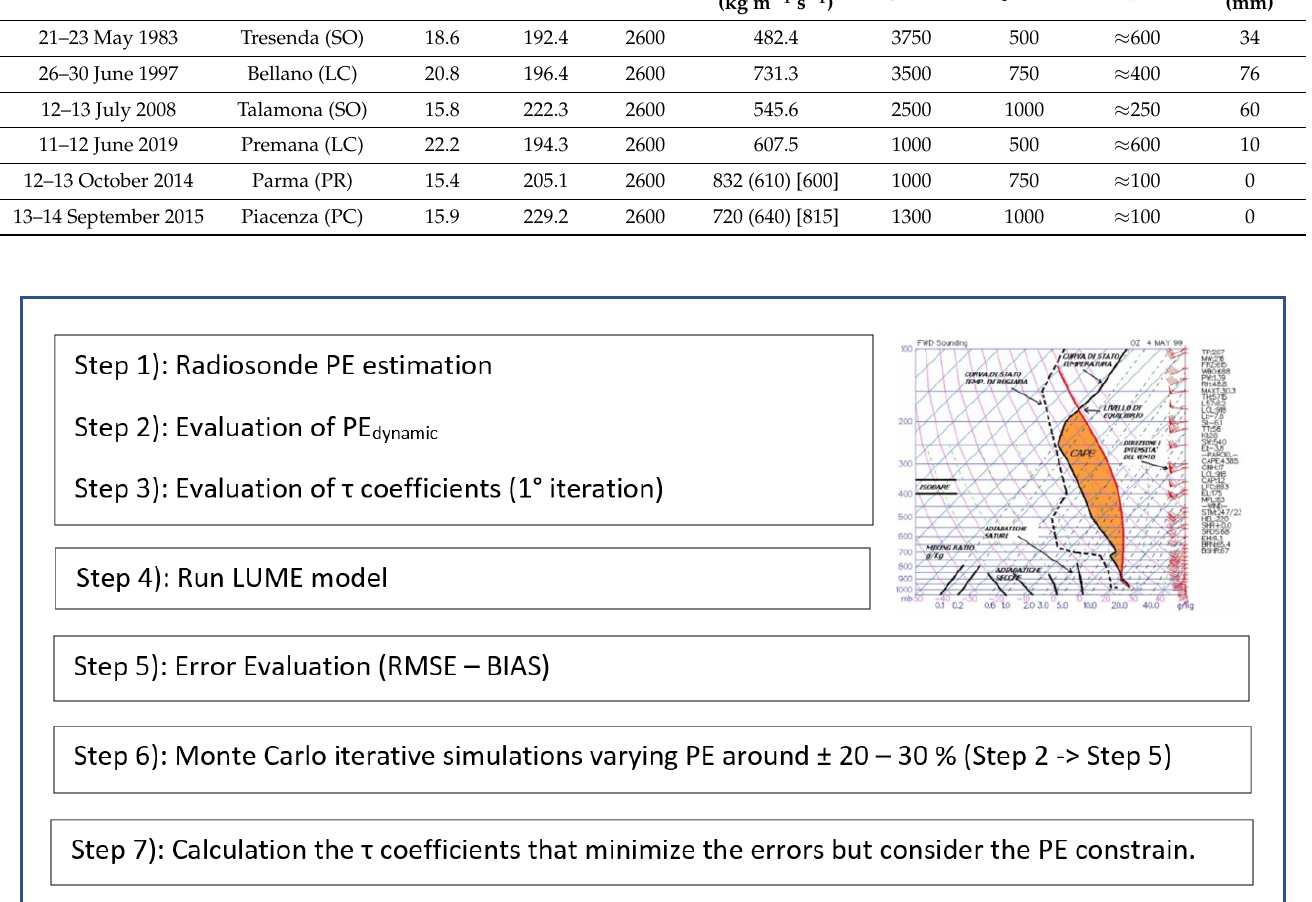
Figure 5. Monte Carlo iterative procedure adopted for estimating deterministically time-delay coefficients through minimization of multiplicative RMSE due to constrained PE.